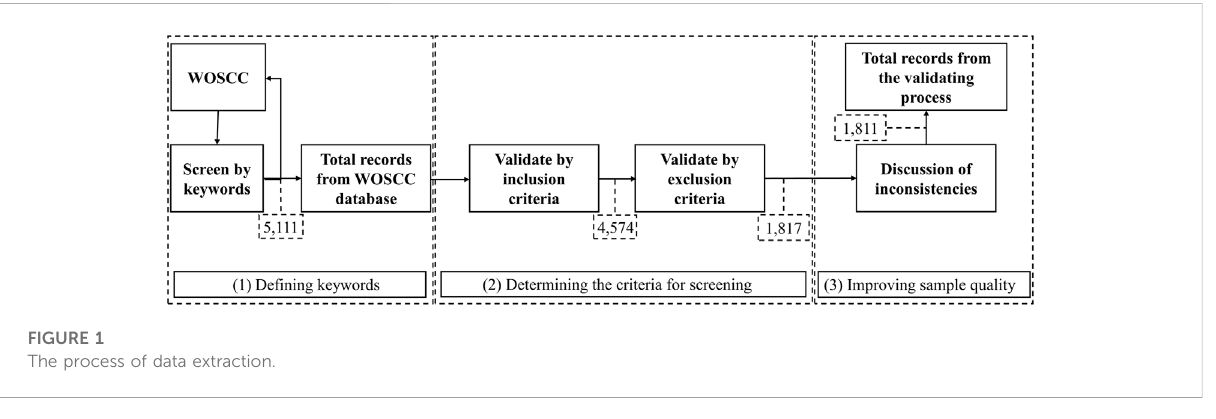
FIGURE 1 The process of data extraction.